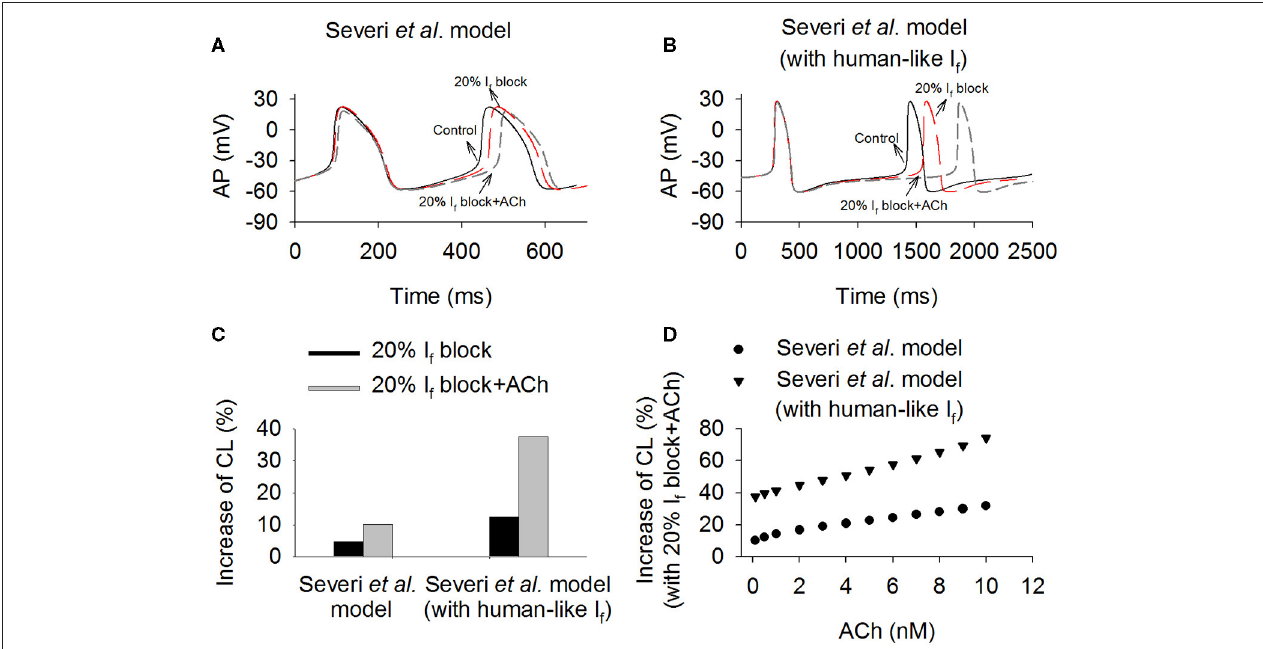
FIGURE 6 | Effects of combined action of ACh and 20% I f reduction on sponteneous action potentials in the Severi et al. model with the rabbit-like and human-like I f formulations. (A,B) Time courses of action potentials in control, I f reduction and combined effect of I f reduction and ACh (0.1nM). (C) The increase of pacemaking CL in the conditions of 20% I f block alone and combined action with ACh (0.1nM). (D) Combined effect of variant concentrations of ACh (from 0.1 to 10nM) and 20% I f block on pacemaking CL in the rabbit-like and human-like I f formulations